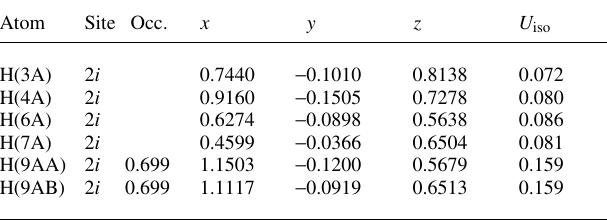
Table 2. Atomic coordinates and displacement parameters (in Å 2 )